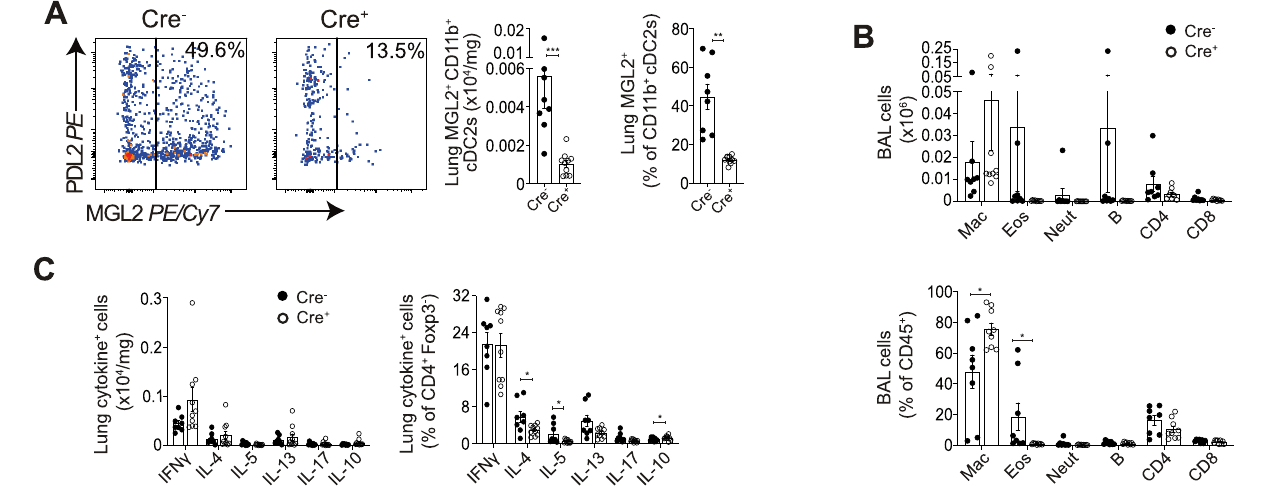
Fig. 6 | Pulmonary IRF4 -dependent cDC2s are required to promote pulmonary type-2 immune responses in pre-patent murine schistosome infection. CD11c Δ Irf4 mice were percutaneously infected with 180 cercariae, and samples taken atd21. A Representative fl owcytometryplots show depletion of lung MGL2 + IRF4 dependent cDC2s. Gate frequencies show % of CD11b + cDC2s. B BAL cell isolates were assessed via fl ow cytometry for macrophages, eosinophils, neu- trophils, B cells, CD4 + and CD8 + T cells. C Lung cell isolates were stimulated with